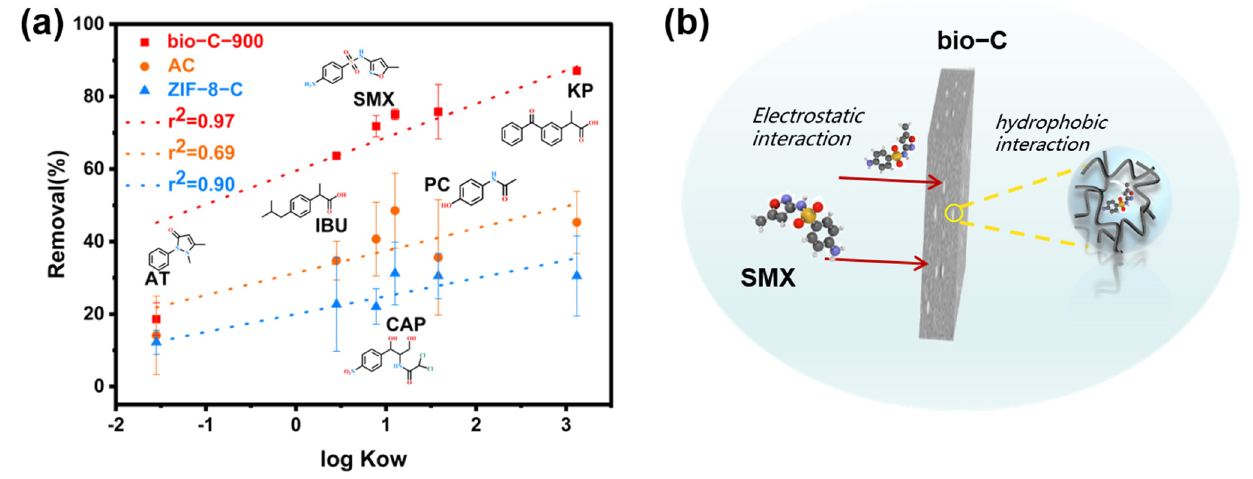
Figure 9. ( a ) Effect of K ow on diverse micropollutants. ( b ) Proposed reaction mechanism.